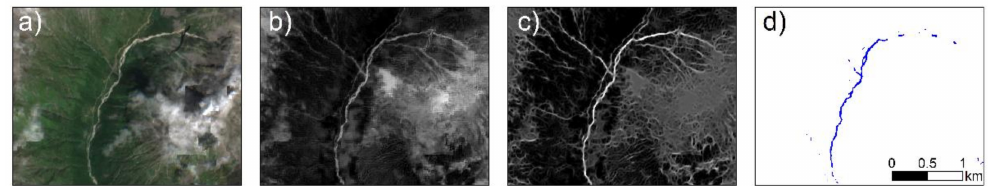
Figure 10. ASRM results in the presence of cloud cover. ( a ) Original Sentinel-2 image. RGB: band 4 (Red), band 3 (Green), band 2 (Blue). ( b ) MNDWI image. ( c ) Gabor filtered MNDWI image. ( d ) ASRM results.